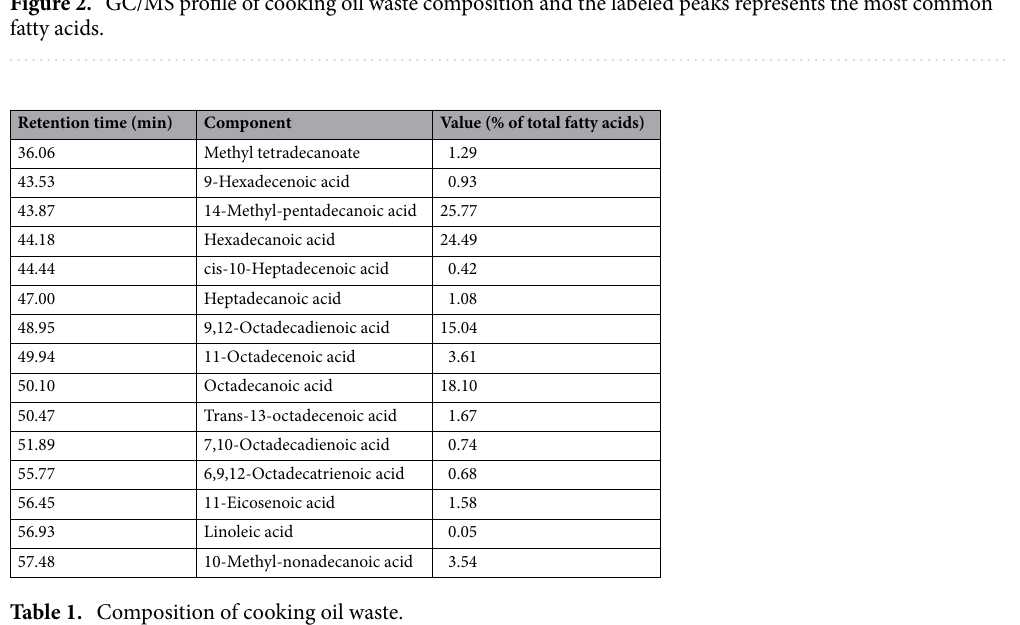
Table 1. Composition of cooking oil